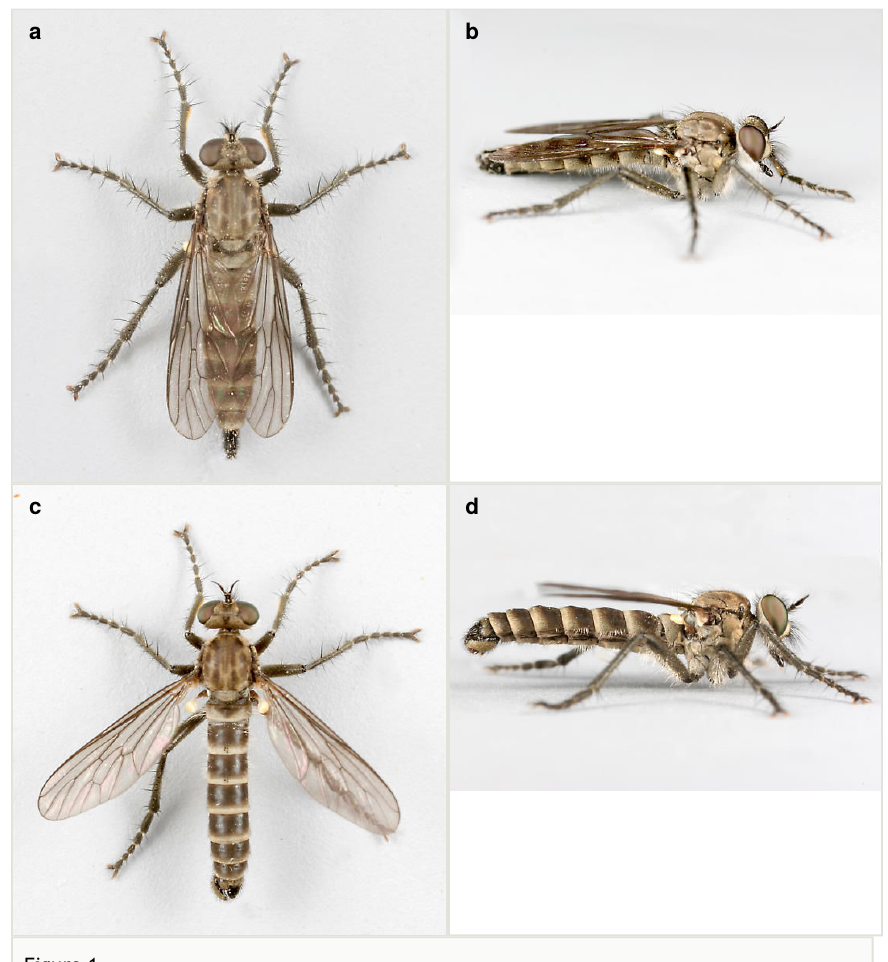
Lasiopogon , probably opaculus . Collected in copula. All photographs by Gayle and Jeanell Strickland, used with